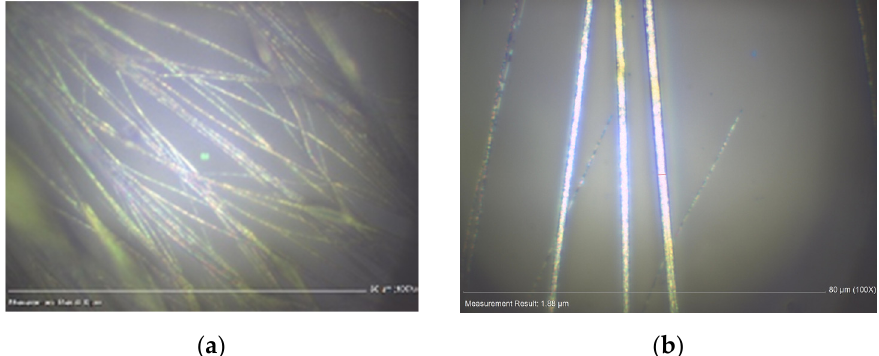
Figure 1. ( a ) The OM image of CH 3 NH 3 PbI 3 perovskite MWs using a 10X objective lens, and ( b ) the OM image of a single CH 3 NH 3 PbI 3 perovskite MW.